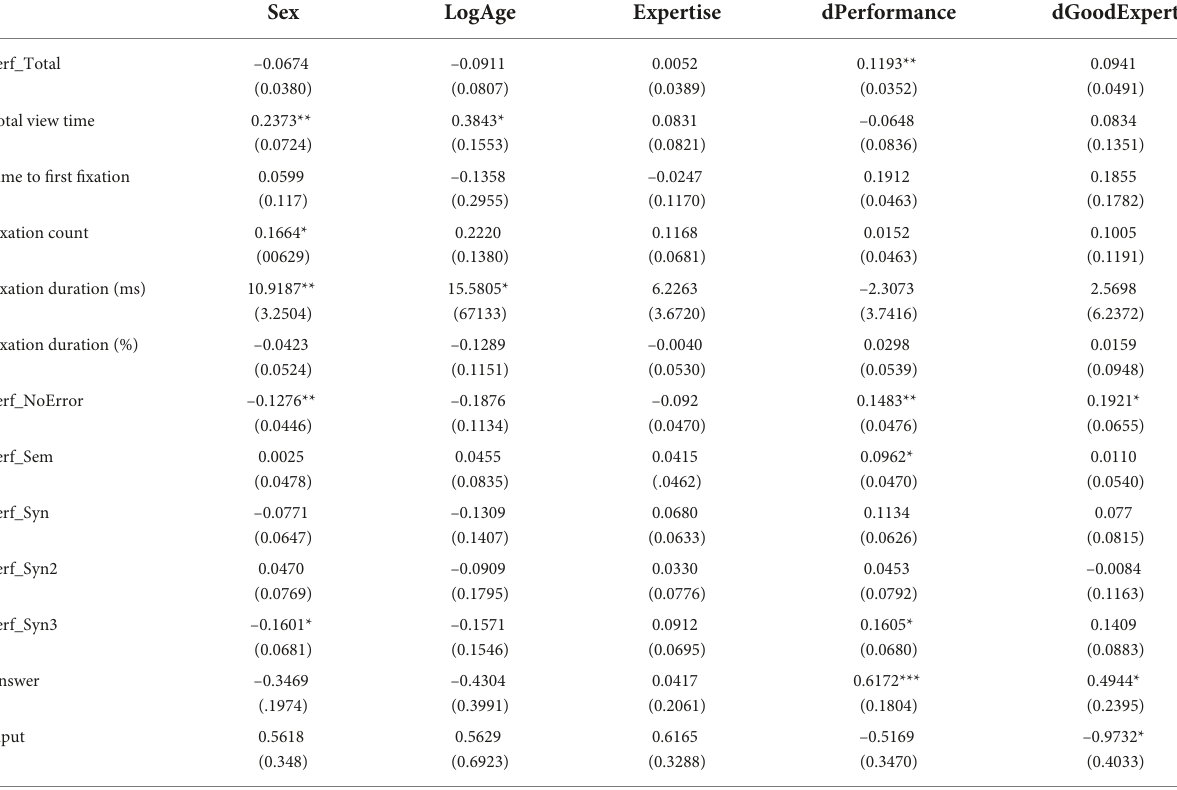
TABLE 1A Results of linear